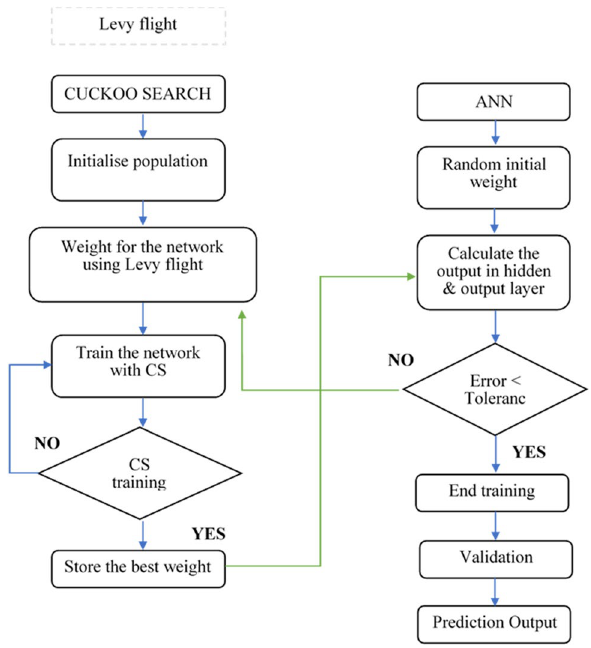
Fig. 3 Proposed hybrid cuckoo search (CS)-artificial neural network (ANN) process